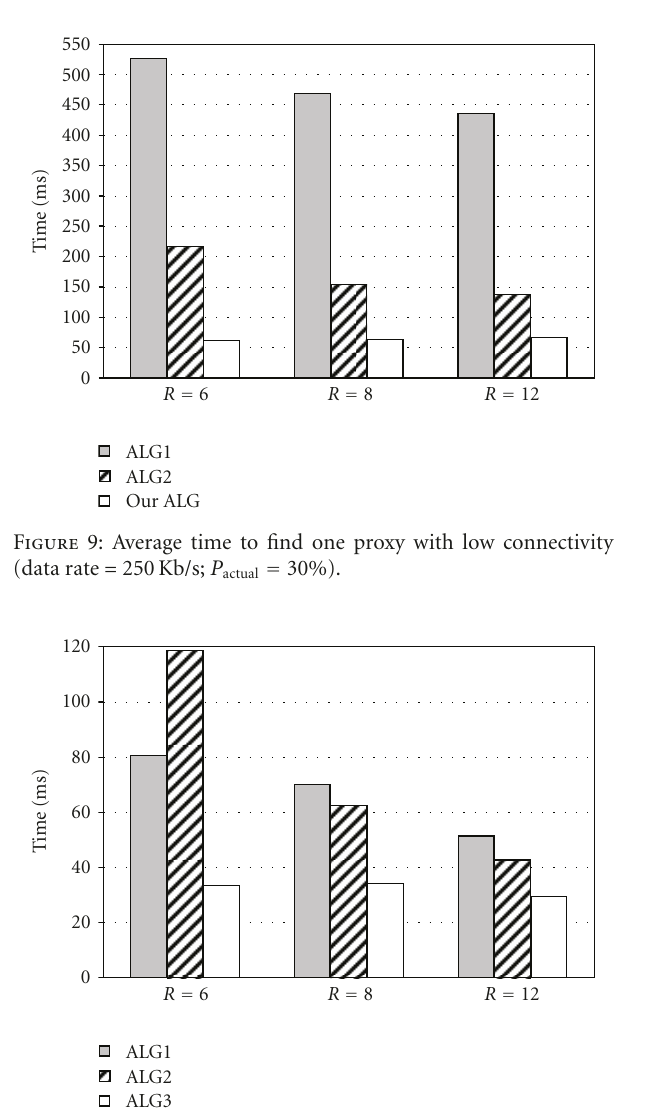
Figure 10: Average time to find one proxy with high connectivity (data rate = 250 Kb/s; P actual = 60%).